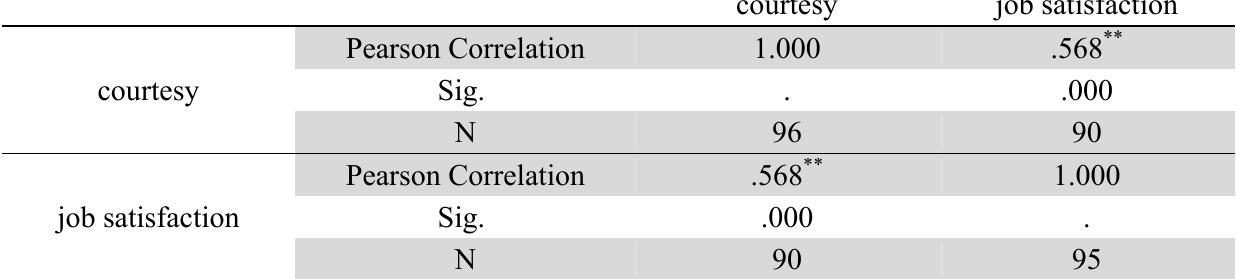
The relationship between courtesy and job